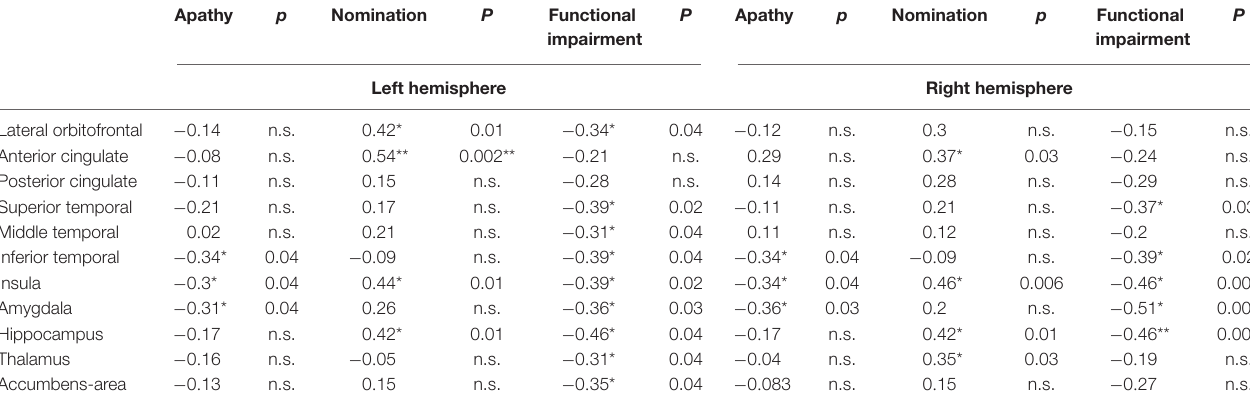
TABLE 4 | Partial correlations between brain volume and apathy severity, nomination score, and percentage of functional impairment in PCD group.